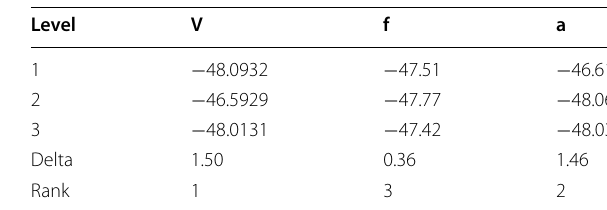
Table 11 S/N response and the delta value of Ymax for each